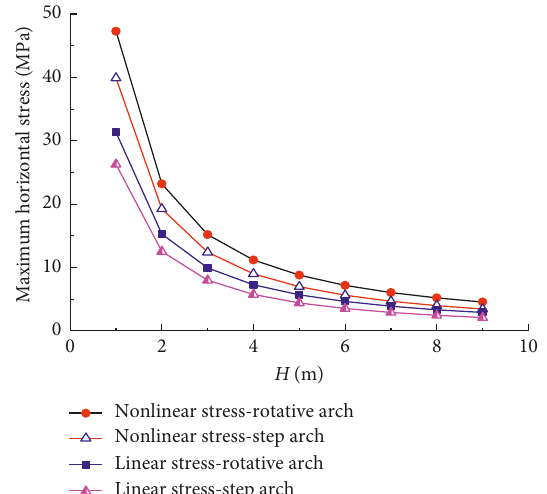
Figure 6: Stability curves of the pressure-arch structure of multiple key